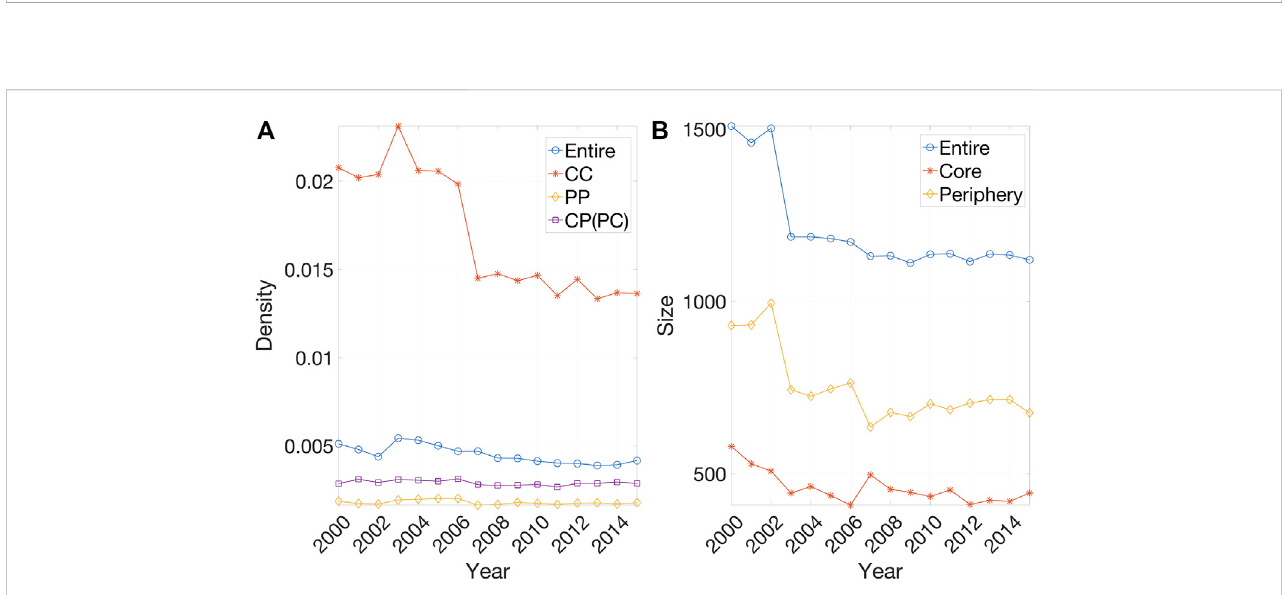
FIGURE 8 (A) Density of the entire network and CC/PP/CP(PC) blocks; (B) the number of nodes of core and periphery boards. The de fi nition of CCP/PP/CP(PC) blocks is explained in Figure 2. In the fi gures, the density of the core – core block increases more than that of the periphery – periphery